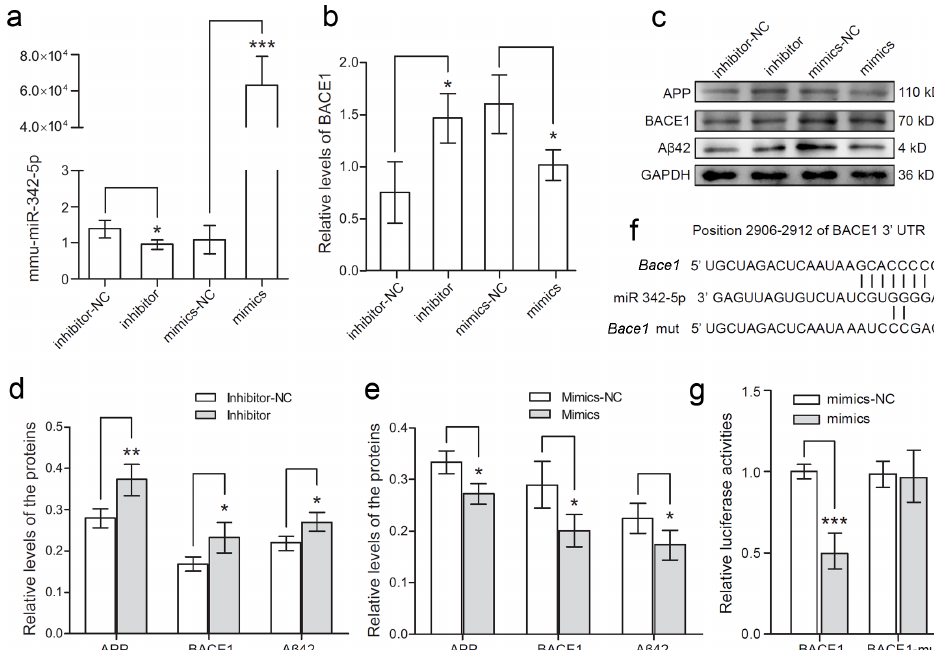
Figure 2. MiRNA-342-5p modulated the expression of Bace1 by targeting its 3 ′ -UTR in mouse hip- pocampal HT-22 neurons. ( a ) MiR-342-5p was detected by RT-PCR assay after the cells were trans- fected with miR-342-5p inhibitors or mimics or their corresponding negative control (NC). *, p < 0.05, ***, p < 0.001. ( b ) BACE1 was detected by RT-PCR assay after the cells were transfected with the above RNA oligonucleotides. *, p < 0.05. ( c ) APP, BACE1, and A β 42 were detected by Western blot assay. GAPDH was used as the internal control. The experiments were performed in triplicate. ( d ) Relative quantification of APP, BACE1, and A β 42 immunoblot bands was performed by